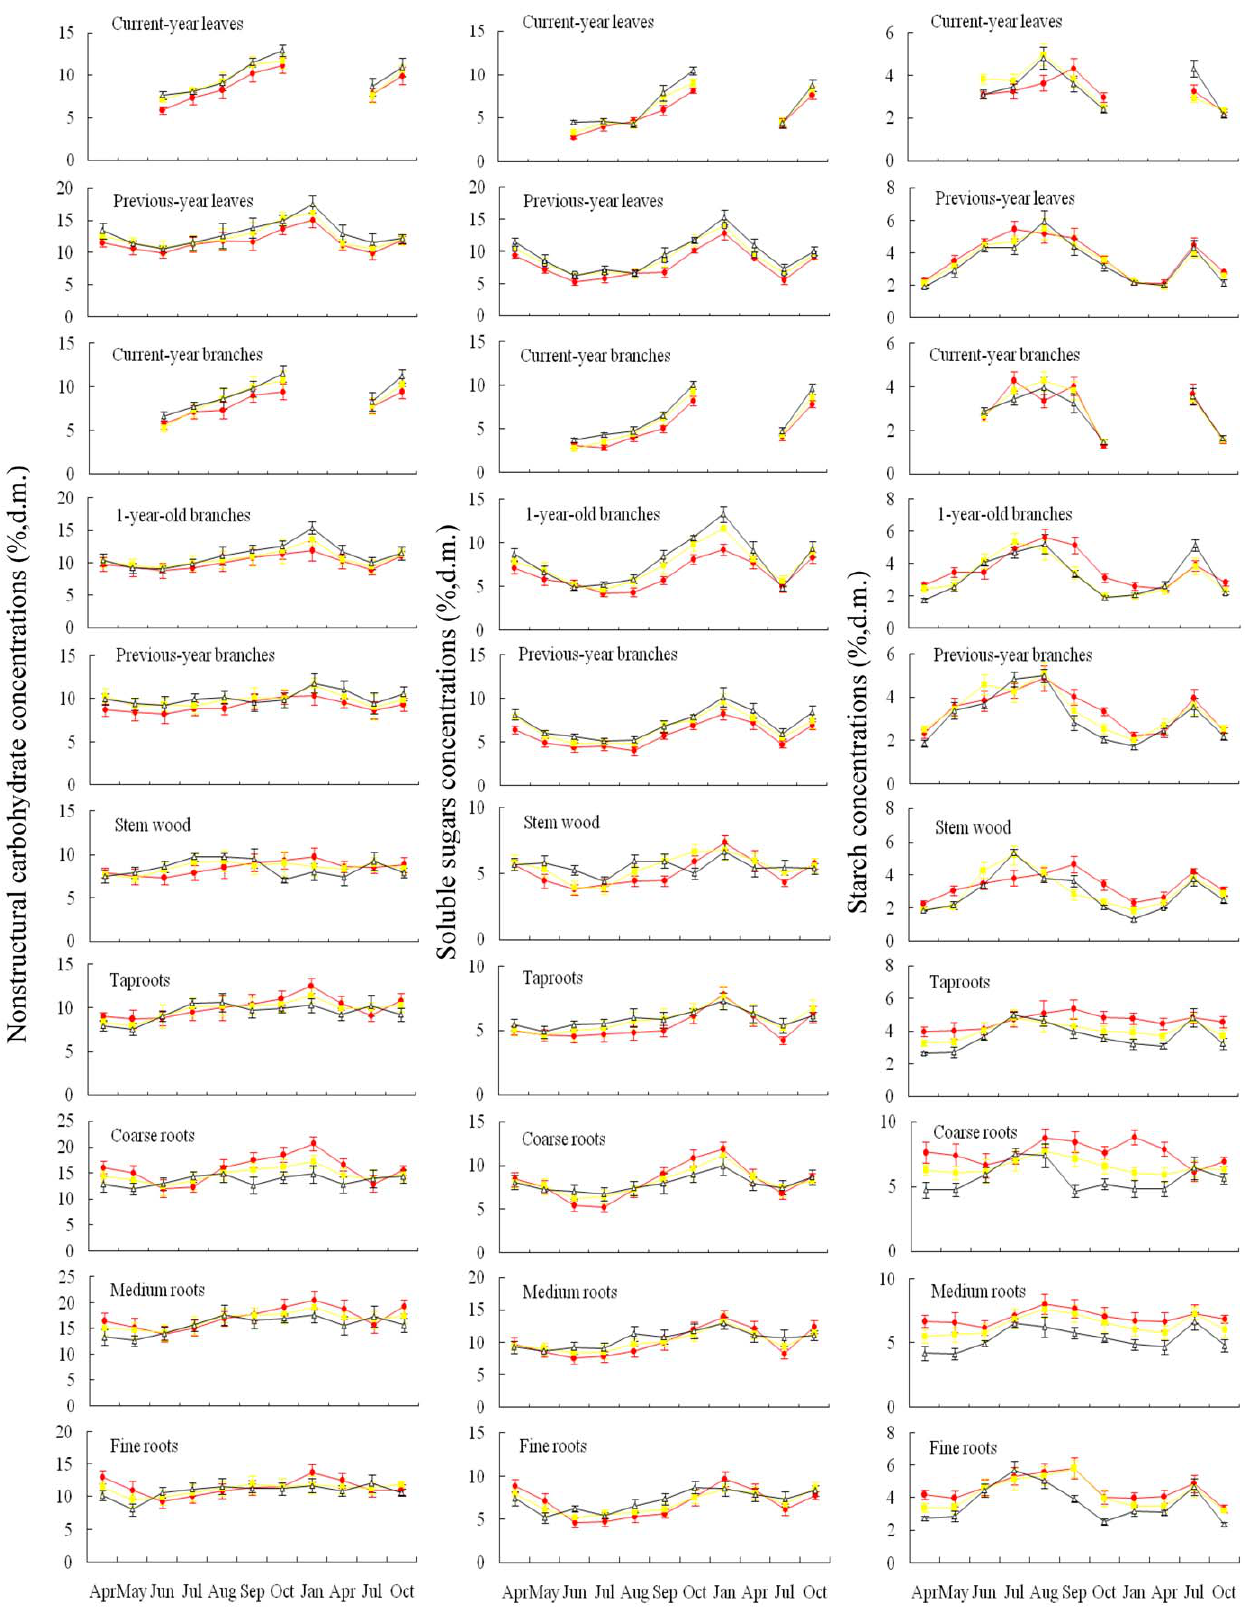
Figure 1. Mean concentrations ( ± 1SE, n =6, % d.m.) of nonstructural carbohydrates (left panels), soluble sugars (middle panels), N and starch (right panels) in relation to sampling time for tissues of Quercusaquifoliodes shrubs grown at 3000 m, 3500 m, and (red)=3000 m a.s.l.; & (yellow)=3500 m a.s.l.; D (black)=3950 m a.s.l. 3950 m a.s.l. on the Mt. Zheduo, SW China. Symbols: doi:10.1371/journal.pone.0034213.g001 PLoS ONE | www.plosone.org